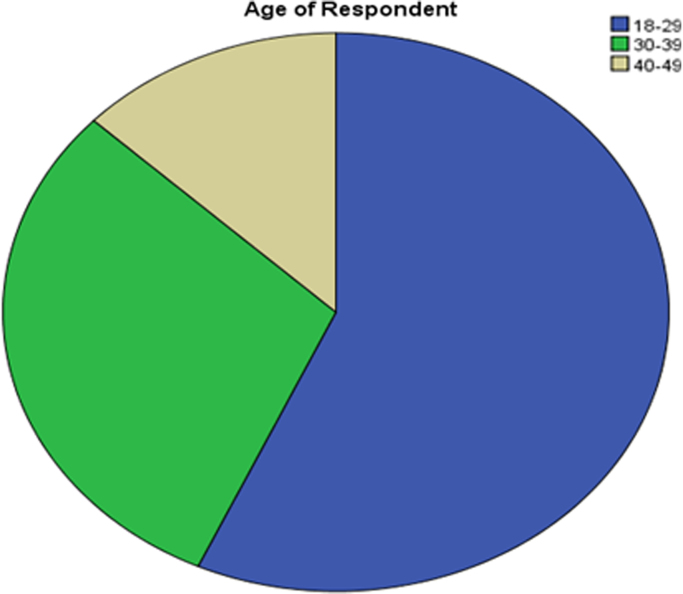
Age of respondents.